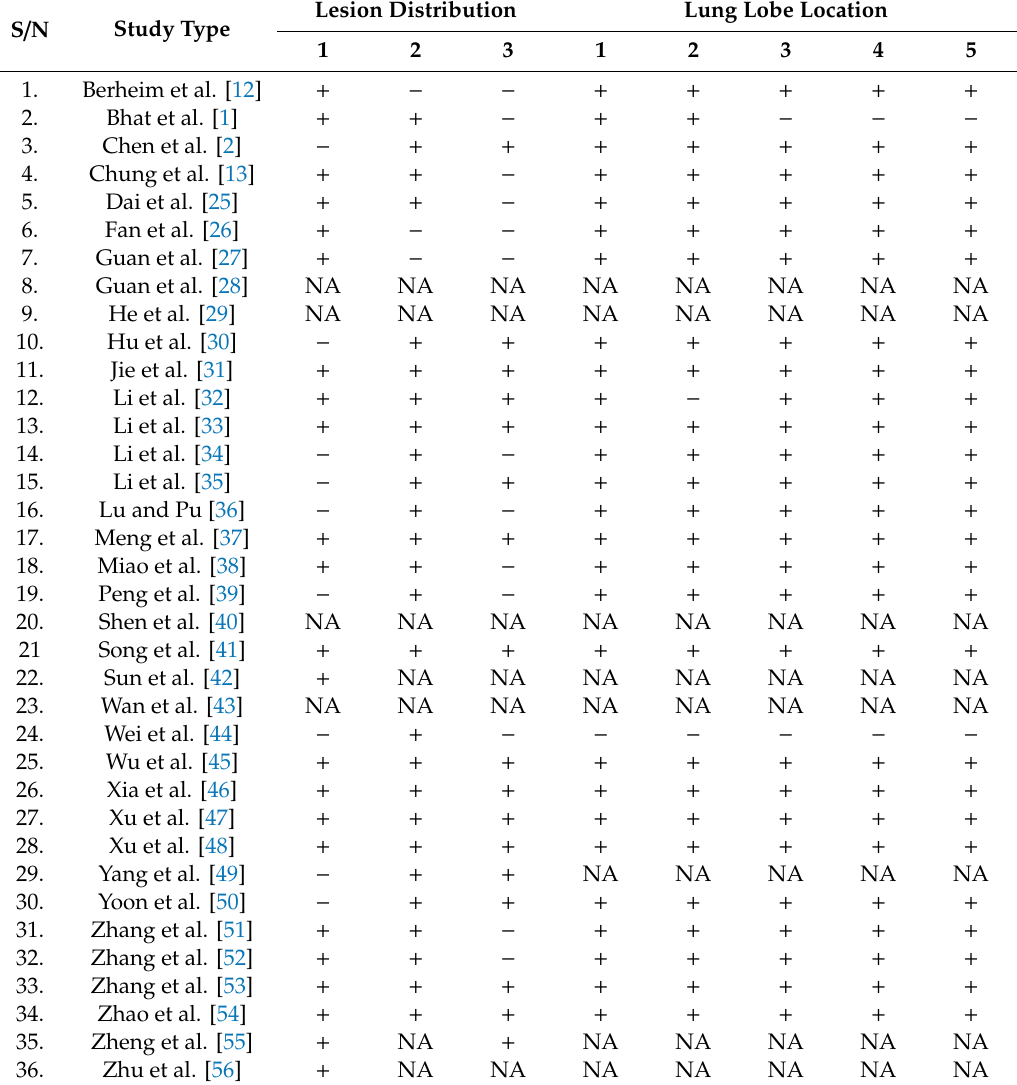
Table 3. Lesion distribution and location of chest computed tomography (CT) abnormality findings in all eligible